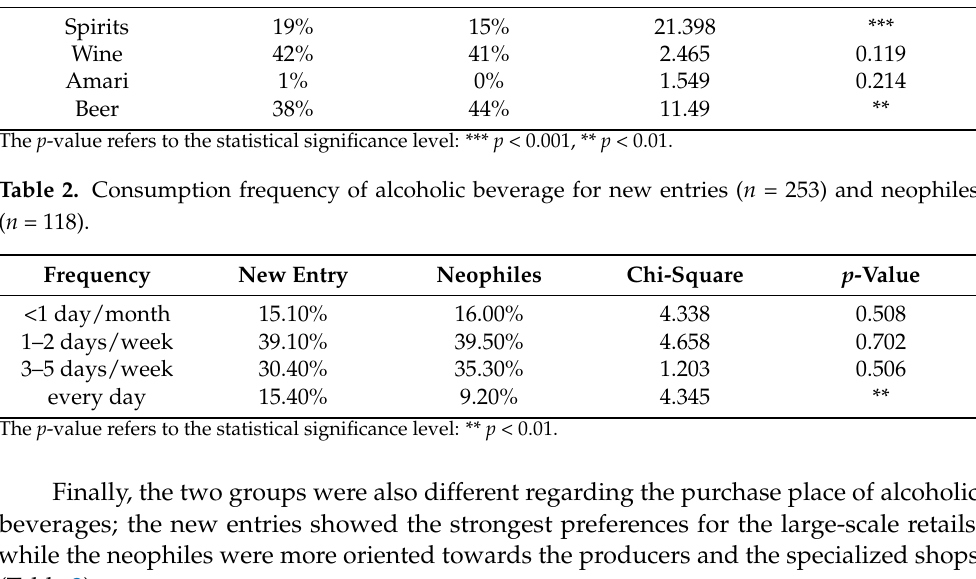
Table 2. Consumption frequency of alcoholic beverage for new entries ( n = 253) and neophiles ( n = 118).